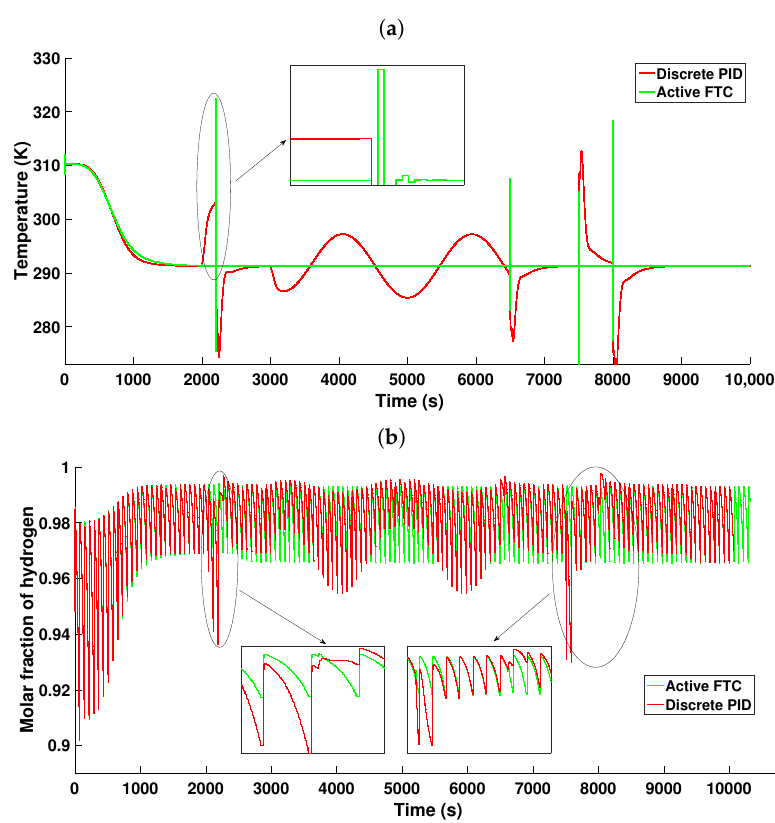
Figure 26. Scenario 2 − Multiple faults: ( a ) control signal generated by the active FTC and discrete PID controller, and ( b ) hydrogen purity with three types of actuator faults (ramp, sine wave, and step) on the PSA virtual